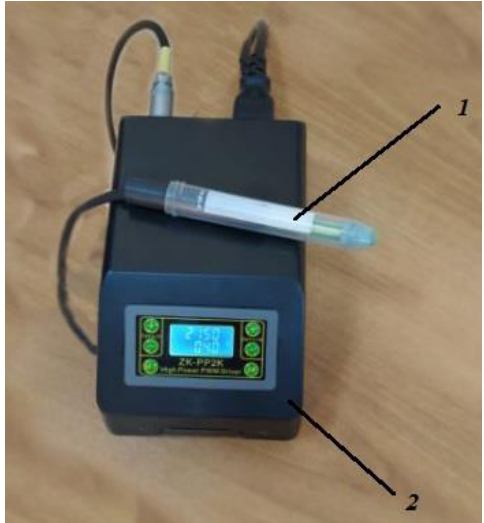
Figure 5. General view of a mobile device for creating cold plasma (CAP): 1 — a replaceable module on the surface of which CAP is created; 2 — hardware control block for DBD CAP creation modes.